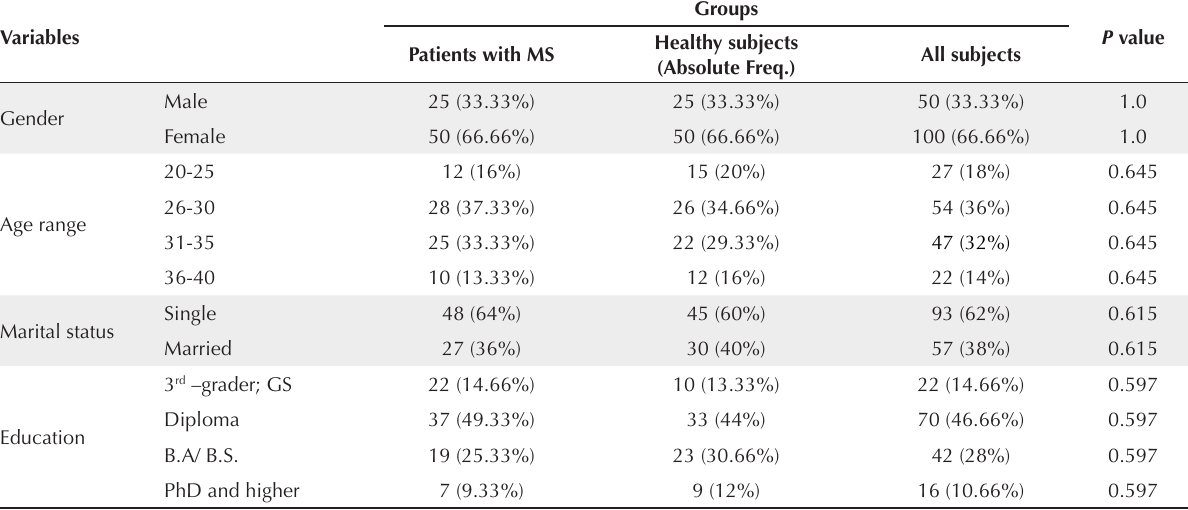
Table 1. Frequencies related to demographic variables of participants Variables